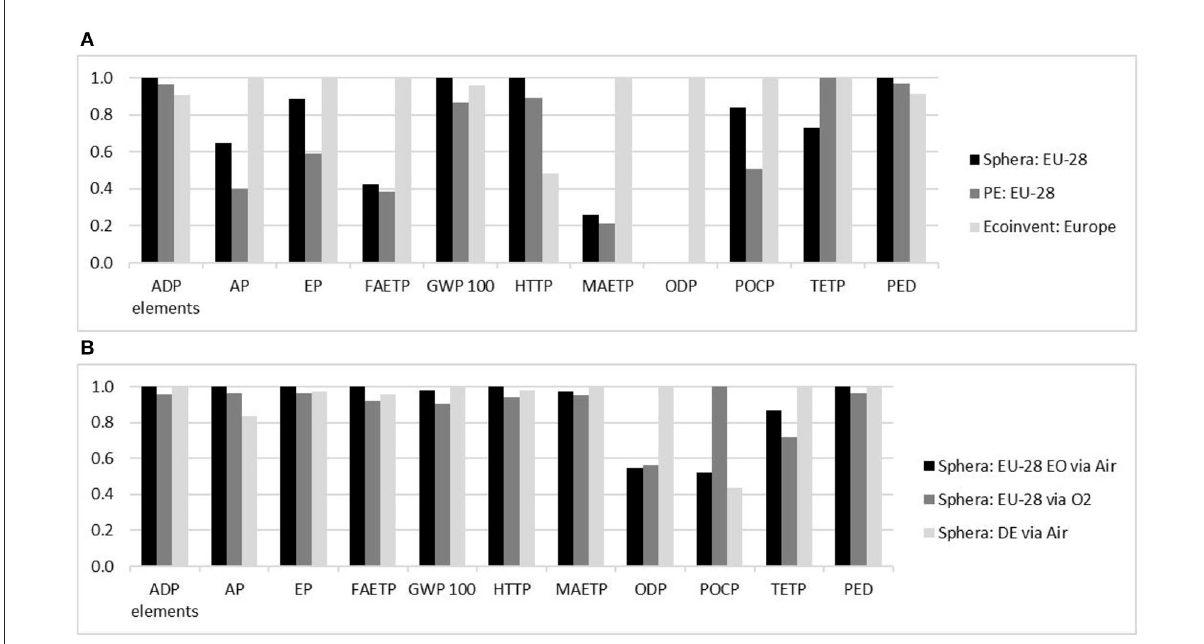
FIGURE5 (A) Normalized benchmark for the production of ethylene : Normalized CML results for the production of 1kg ethylene by processes located in Europe provided by Sphera, PlasticsEurope (PE) and ecoinvent databases. (B) Normalized benchmark for production of ethylene oxide : Normalized CML results for the production of 1kg EO by processes located in Europe provided by Sphera. Source: Own illustration based on data from (A) (GaBi sphera Plastics Europe, 2008; Hischier, 2010; GaBi sphera, 2020d) and (B) (GaBi sphera, 2020e,f,g).